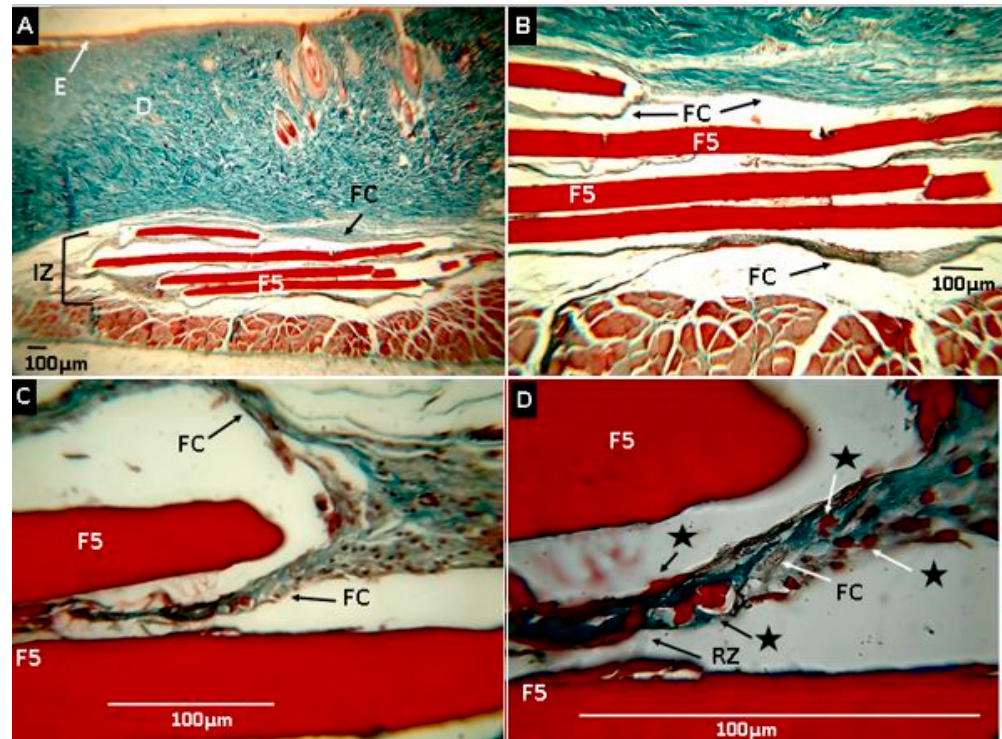
Figure 15. Histological analysis of experimental sample F5 (CS:PVA: CS-g-CNO 29.00:70.00:1.00). Magnifications are as follows: ( A ) 4 × H&E, ( B ) 10 × H&E, ( C ) 40 × MT, ( D ) 100 × MT. E: epidermis. D: Dermis. FC: Fibrous capsule. IZ: implanted zone. RZ: Reabsorption zone. Stars: Fragments of material being reabsorbed. F5: Film formulation 5 (CS:PVA:CS-g-CNO 29.00:70.00:1.00). Hematoxylin and eosin (H&E) and Masson’s trichrome stain (MT) techniques.